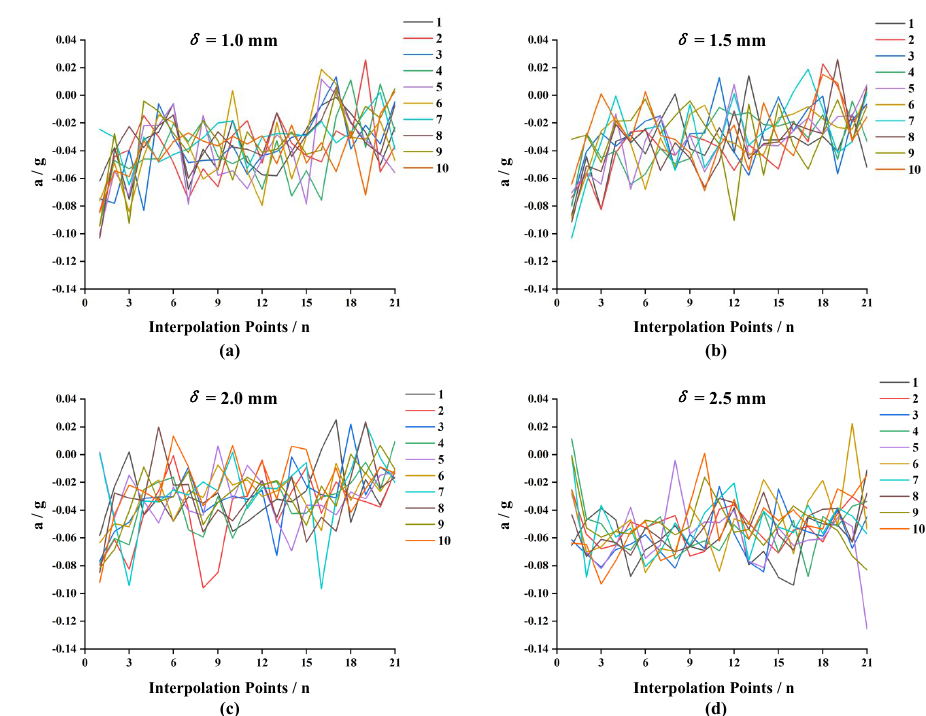
Figure 9. Statistics of the acceleration variation on the Y -axis, consisting of four sets of bark consump- tion